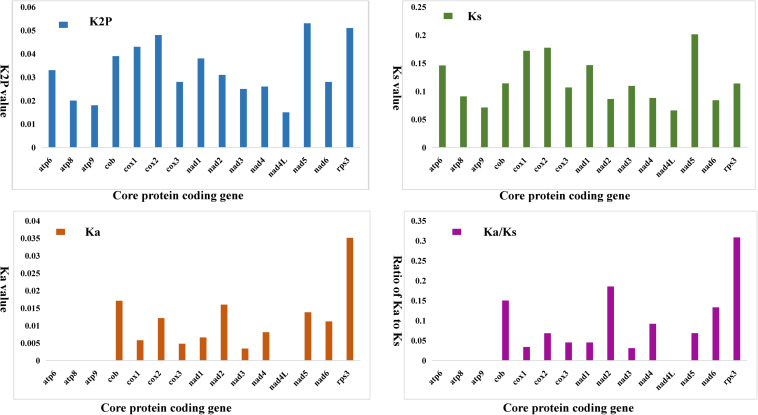
Genetic analysis of 15 protein-coding genes conserved in two Phallus mitogenomes. K2P, the Kimura-2-parameter distance; Ka, the mean number of non-synonymous substitutions per non-synonymous site; Ks, the mean number of synonymous substitutions per synonymous site.